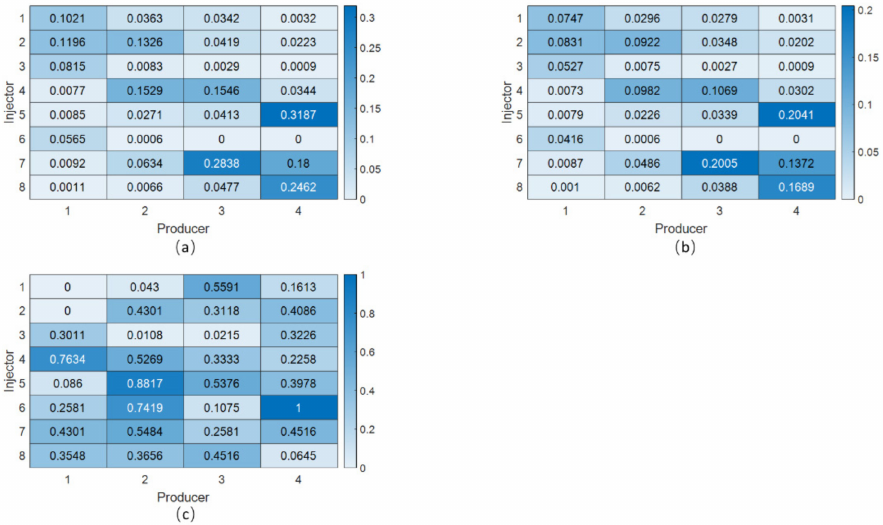
Figure 16. The heatmaps of the inter-well connectivity analysis by KINN-tansig and KINN-Gaussian for the Egg reservoir case: ( a ) KINN-tansig; ( b ) KINN-Gaussian; ( c )